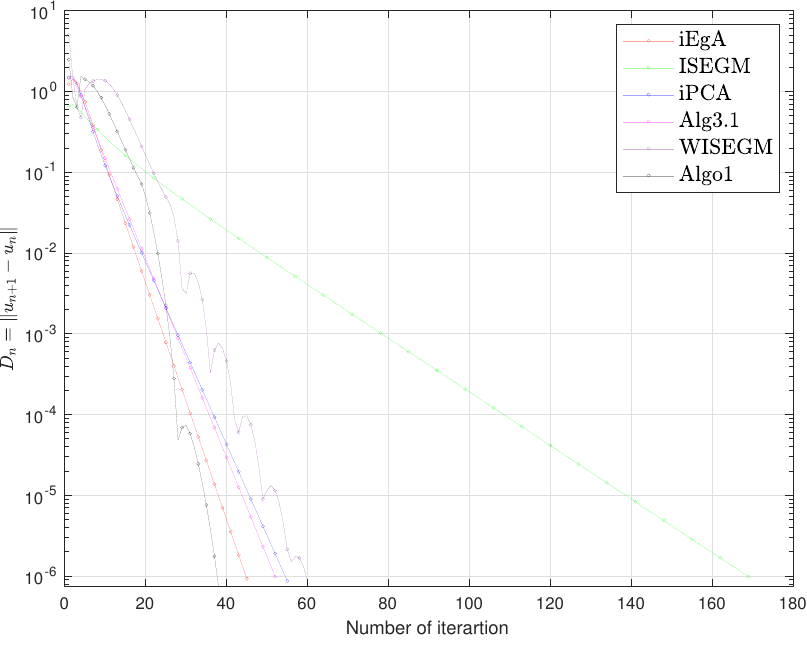
Figure 5. Example 2: Numbers of iterations are 45, 169, 155, 52, 60, 38 respectively.